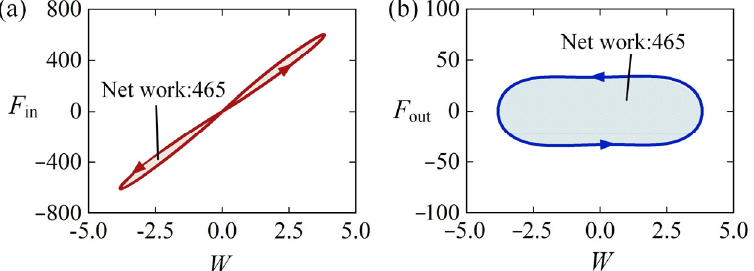
Figure 7. The mechanism of self-sustained Euler buckling of the LCE rod shown in Figure 3c,d. ( a ) F in vs. W ; ( b ) F out vs. W . During the self-sustained Euler buckling of the LCE rod, the damping dissipation from the system equals to the work done by the excitation force.